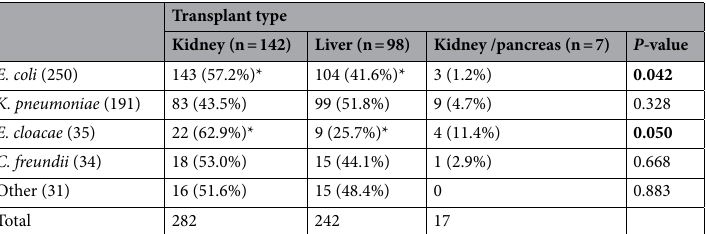
Table 2. Distribution of 541 multidrug-resistant Enterobacterales recovered from 247 patients according to transplant type. *Statistically significant differences (bold type) were found in the prevalence of bacterial species between kidney and liver transplant. Other species included: 9 Morganella morganii , 7 Klebsiella oxytoca , 6 Proteus mirabilis , 5 Enterobacter aerogenes , 2 Citrobacter braakii , 1 Enterobacter asburiae and 1 Citrobacter koseri.